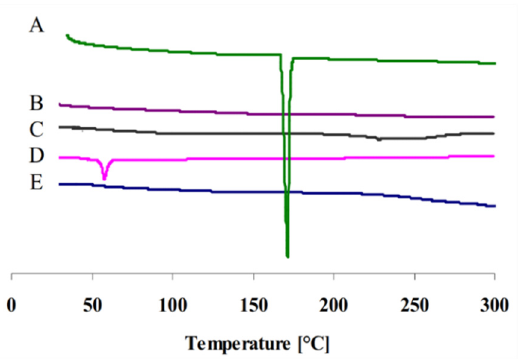
Figure 2. DSC thermograms of plain gliclazide ( A ), gliclazide-loaded cubosomal nanoparticles ( B ), blank cubosomal nanoparticles ( C ), P407 ( D ), and GMO ( E ).